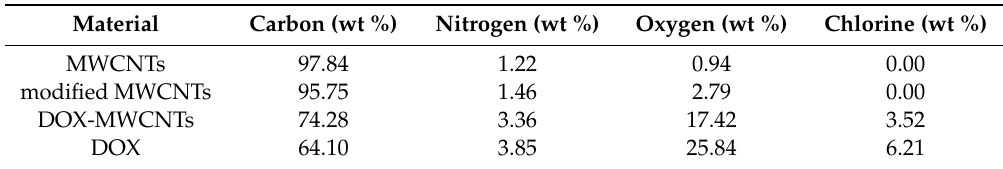
Table 1. Chemical composition determined via EDS.